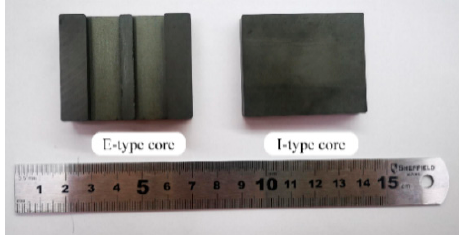
Figure 12. Flux distribution of the improved EIE (E-type and I-type and E-type) core structure.